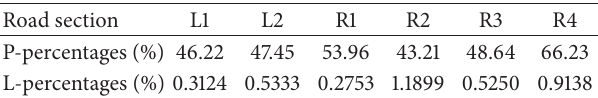
Table 1: Percentages of positive H-yaw angles and of large H-yaw angles in the cornering